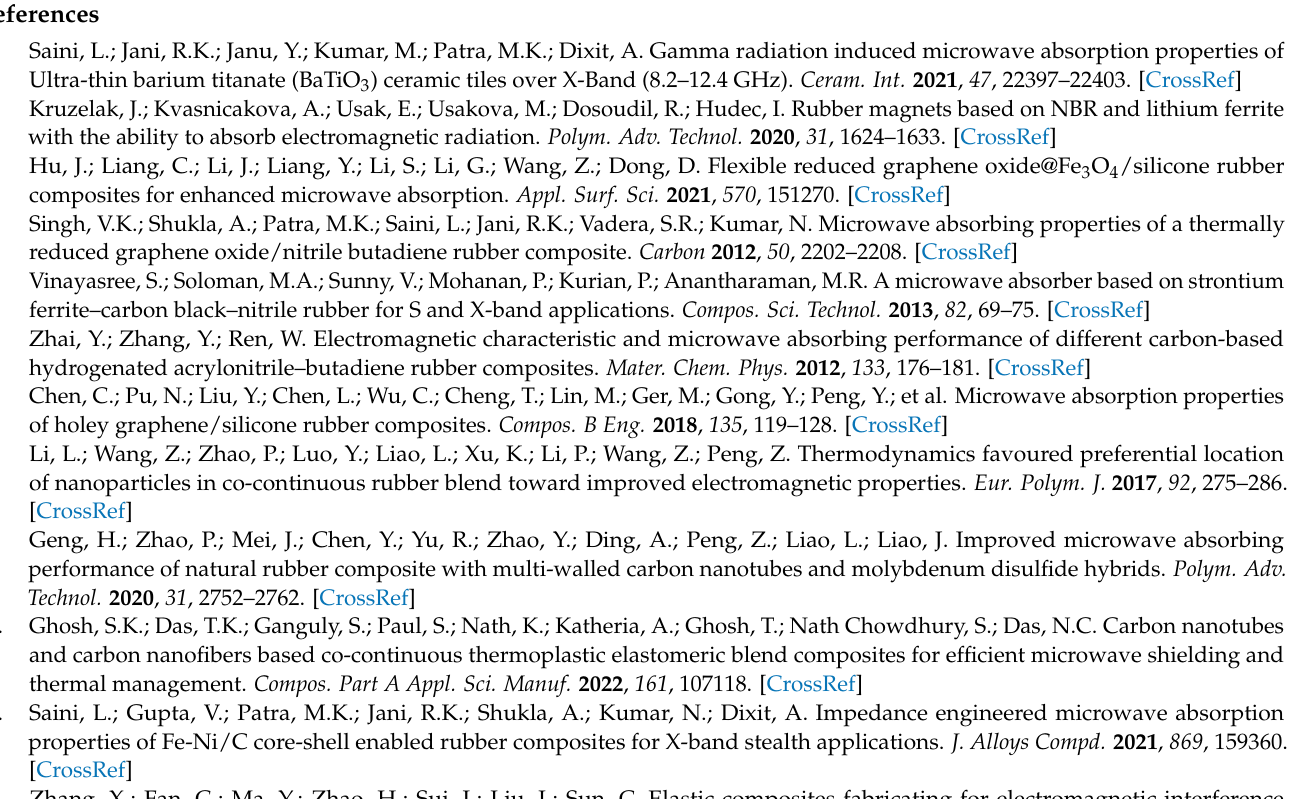
(b) parts of the complex permittivity of PPyNT/NR/NBR (50/50) with different PPyNT contents; Figure S4: TEM images of 6 phr PPyNT filled NR/NBR composites with different ratios of NR/NBR: (a) 10/90; (b) 30/70; (c) 50/50; (d) 70/30; (e) 90/10; Figure S5: Attenuation constant of 6 phr PPyNT filled NR/NBR composites with different ratios of NR/NBR; Figure S6: 2D contour maps of | Z in /Z 0 | values of 6 phr PPyNT filled NR/NBR composites with different ratios of NR/NBR: (a) 10/90; (b) 30/70; (c) 50/50; (d) 70/30; (e)